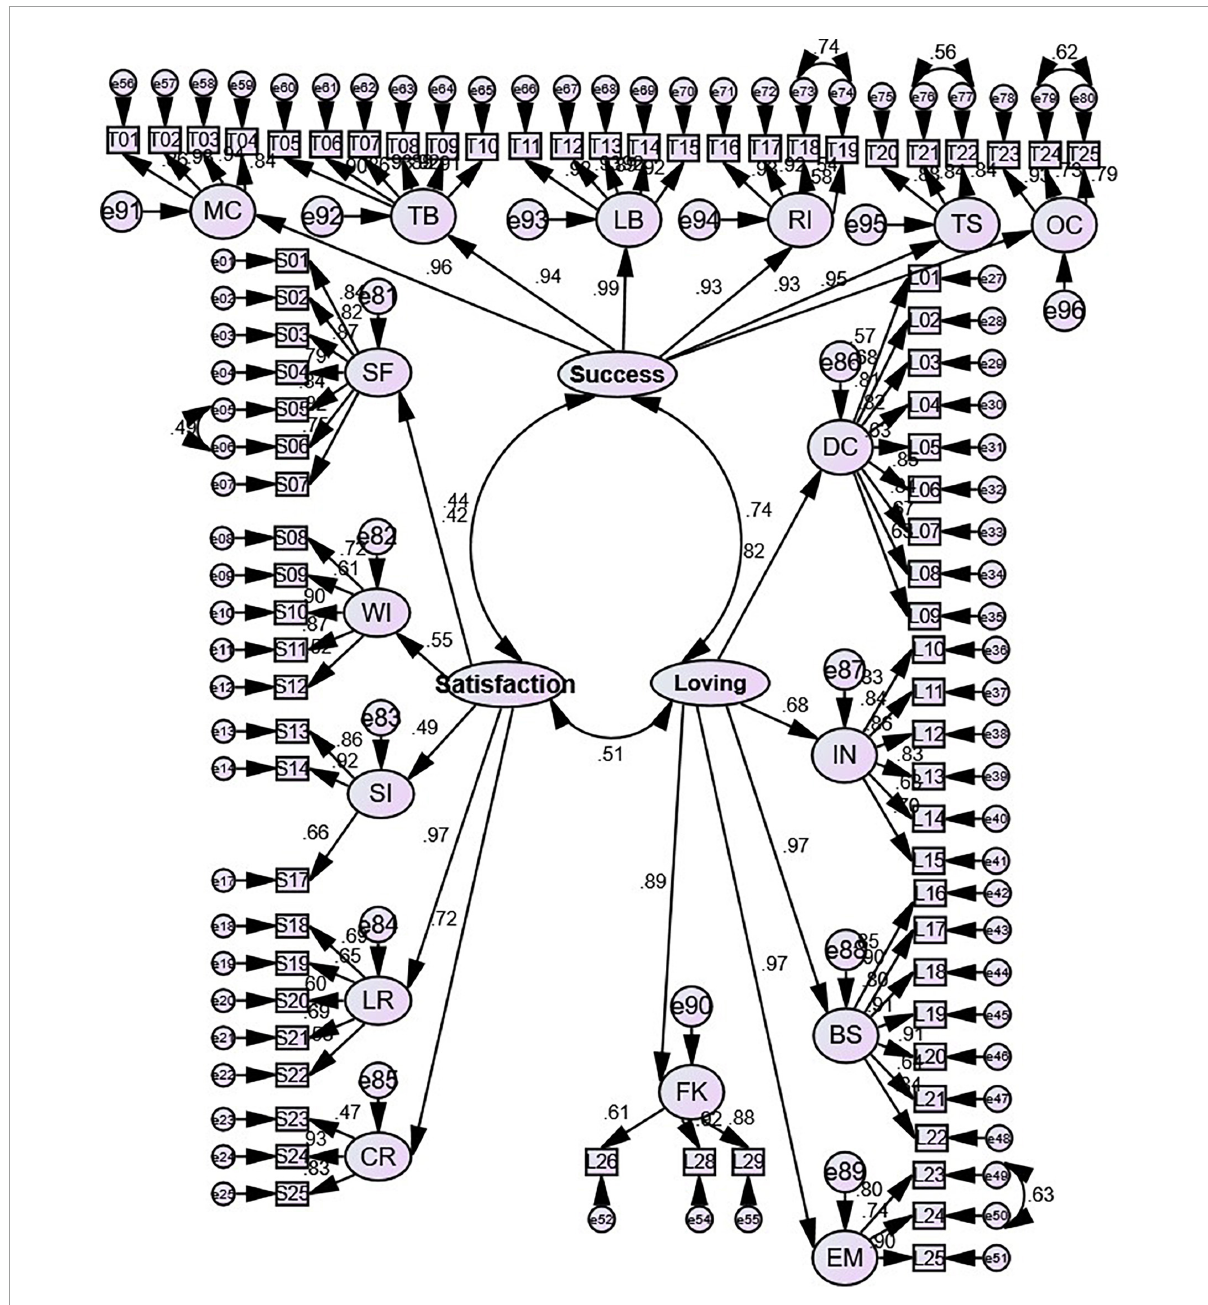
FIGURE1 The final modified CFA model with standardized